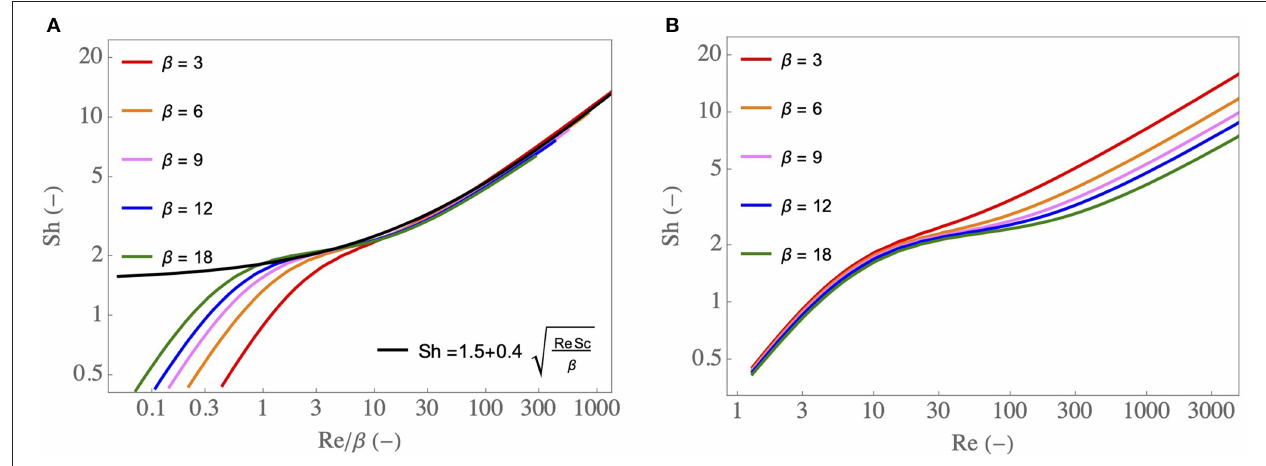
FIGURE 3 | (A) Sh as a function of Re /β , for various β , as well as an approximate expression Sh = 1.5